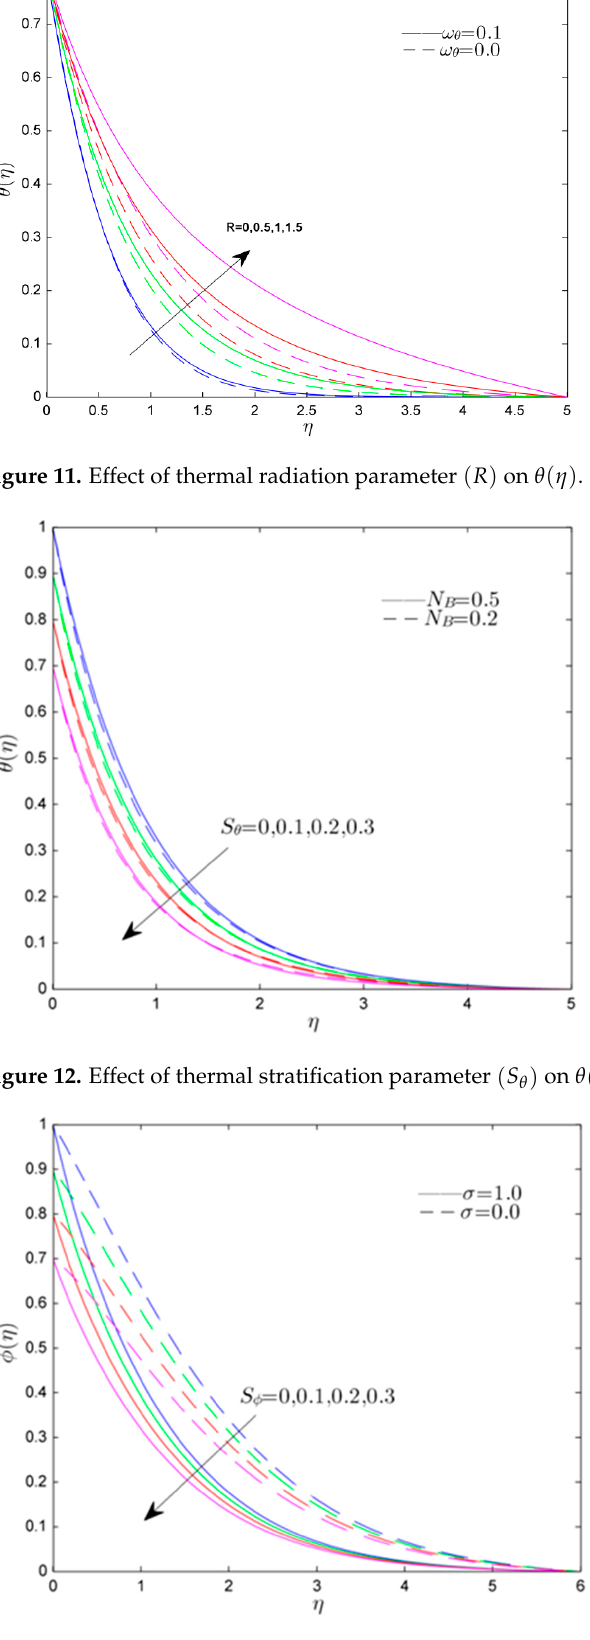
Figure 13. Effect of Solutal stratification (𝑆 (cid:3109) ) on 𝜙(𝜂) .